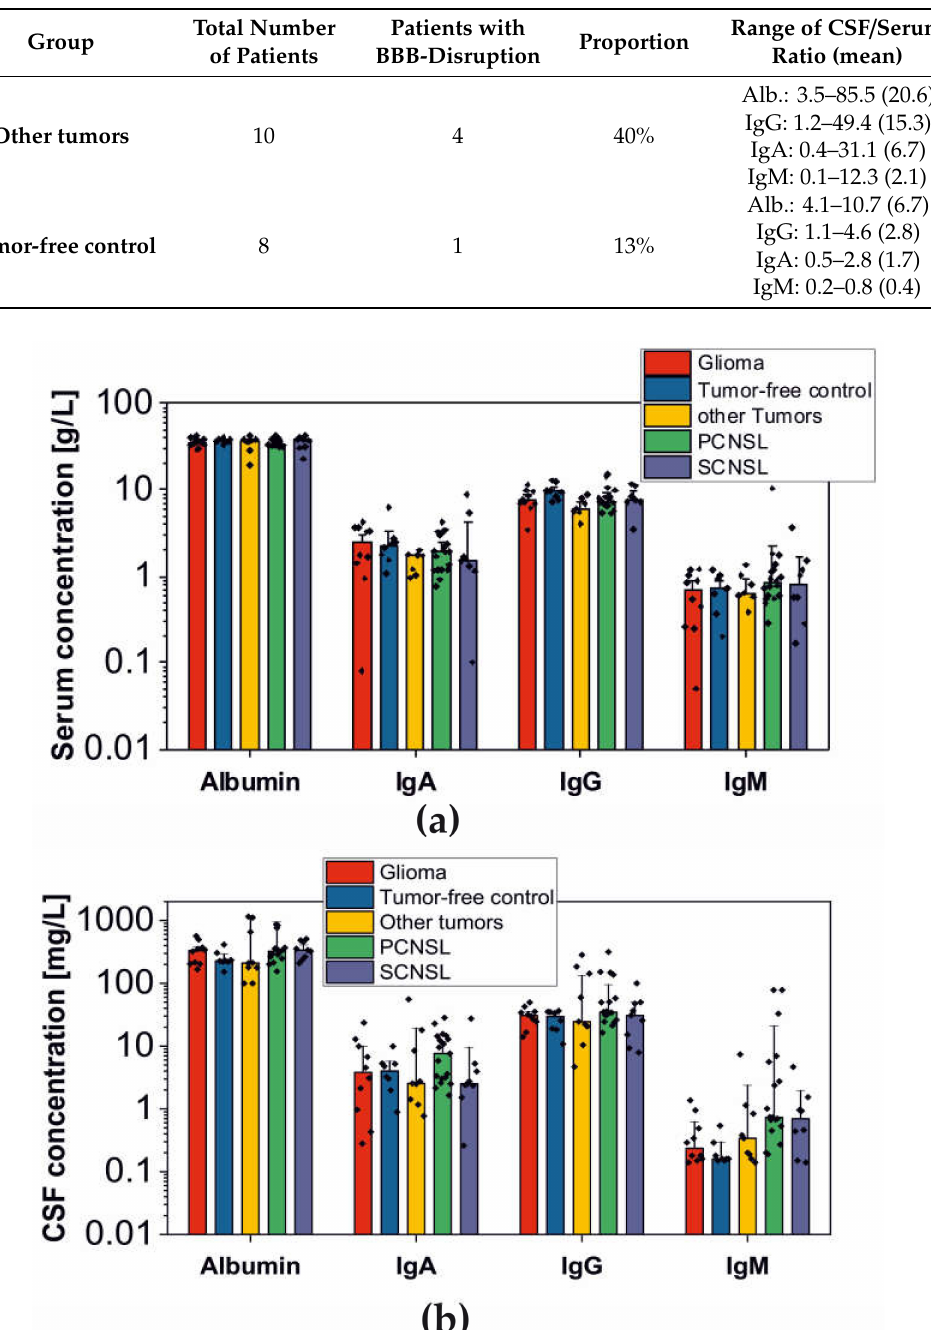
Figure 1. Overview of protein concentration obtained by ELISA (discovery cohort). The data was considered for the determination of blood–brain barrier (BBB) dysfunction. Median values and standard errors are shown (primary central nervous system lymphomas (PCNSL): n = 19, secondary central nervous system lymphomas (SCNSL): n = 9, glioma: n = 10, other tumors: n = 10, tumor-free control: n = 8). ( A ) Concentrations of albumin, IgG, IgA and IgM in serum and ( B ) cerebrospinal fluid